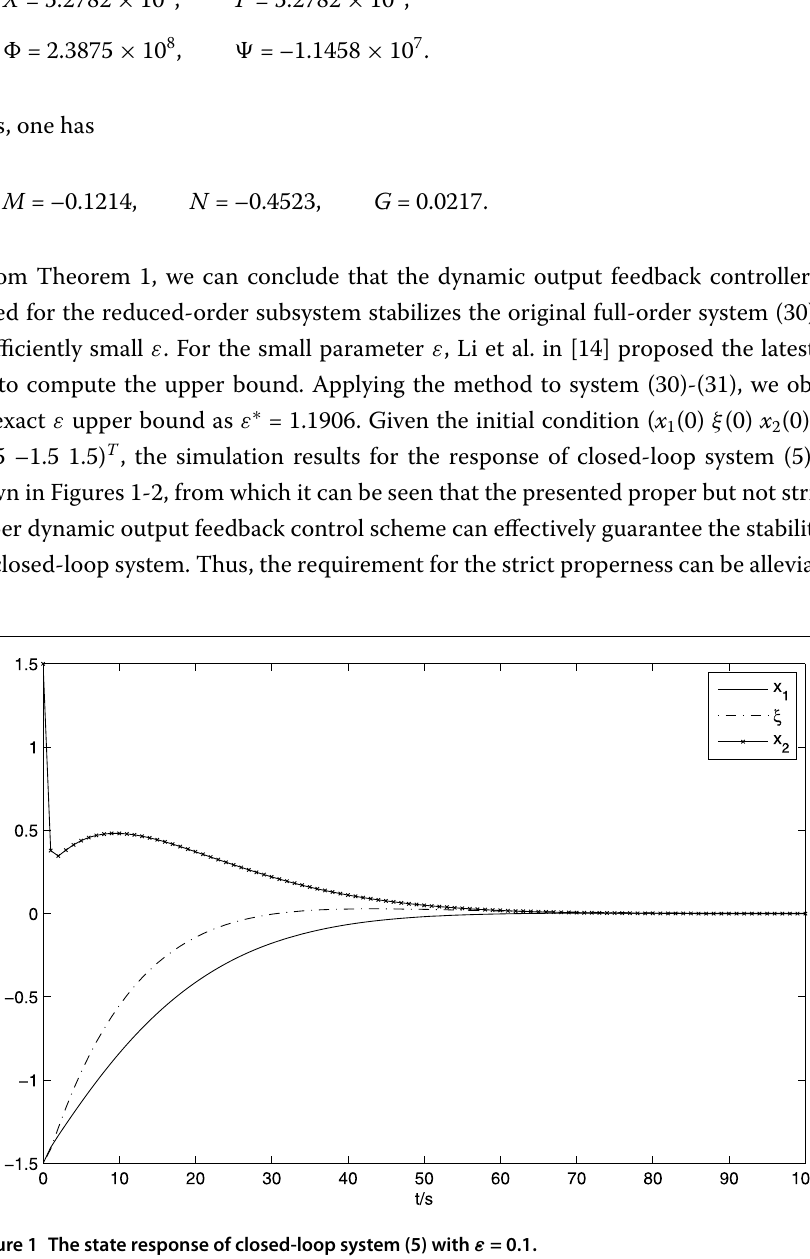
Figure 1 The state response of closed-loop system (5) with ε =